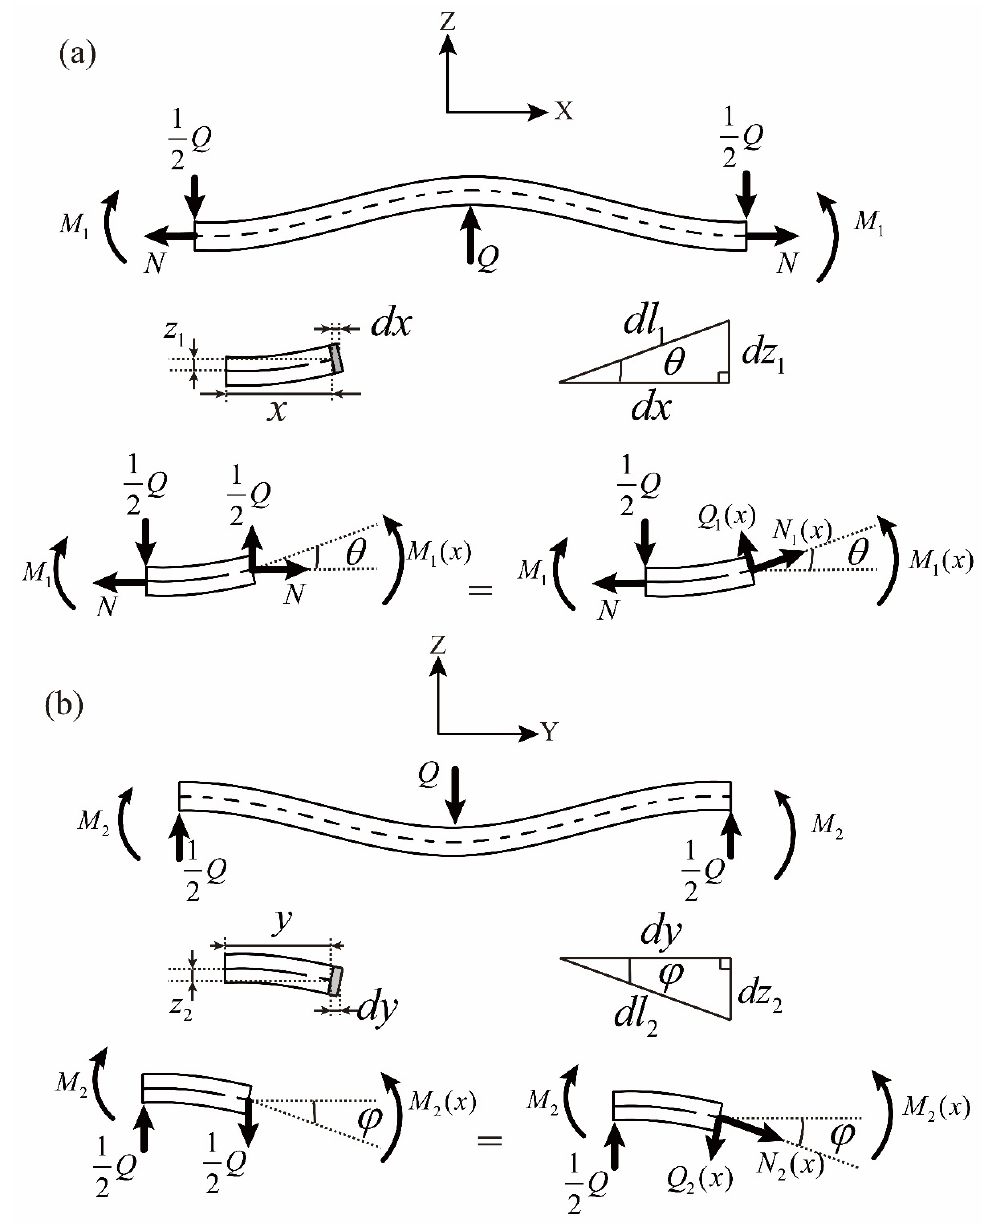
Figure 5. Force analyses of the studied yarn segments: ( a ) force analysis of the warp yarn segment; ( b ) force analysis of the weft yarn segment.